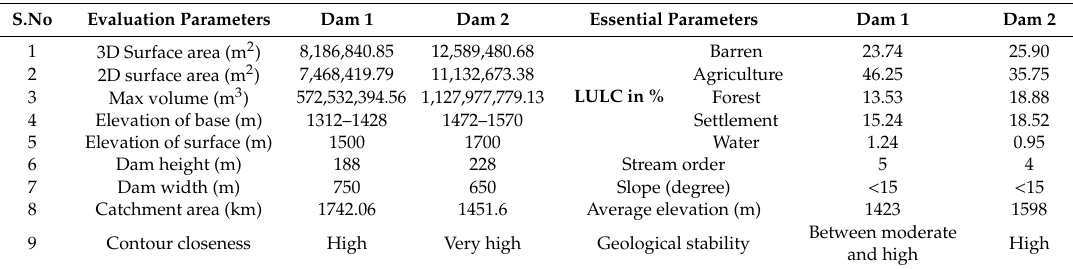
Table 7. Evaluation and essential parameters of dam